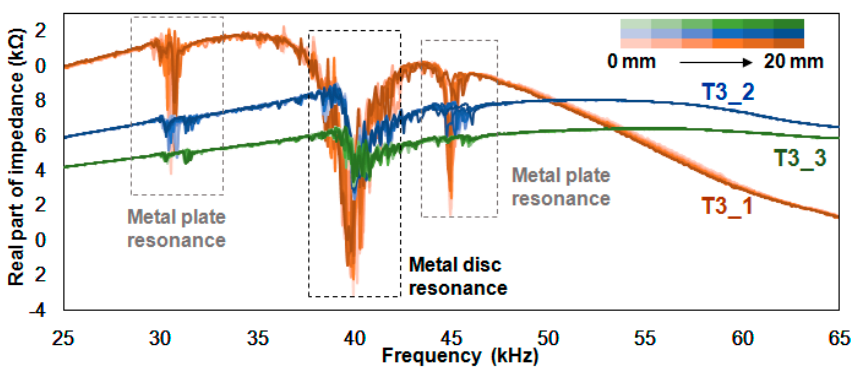
Figure 6. Impedance signatures for the T3_1, T3_2 and T3_3 experiment.